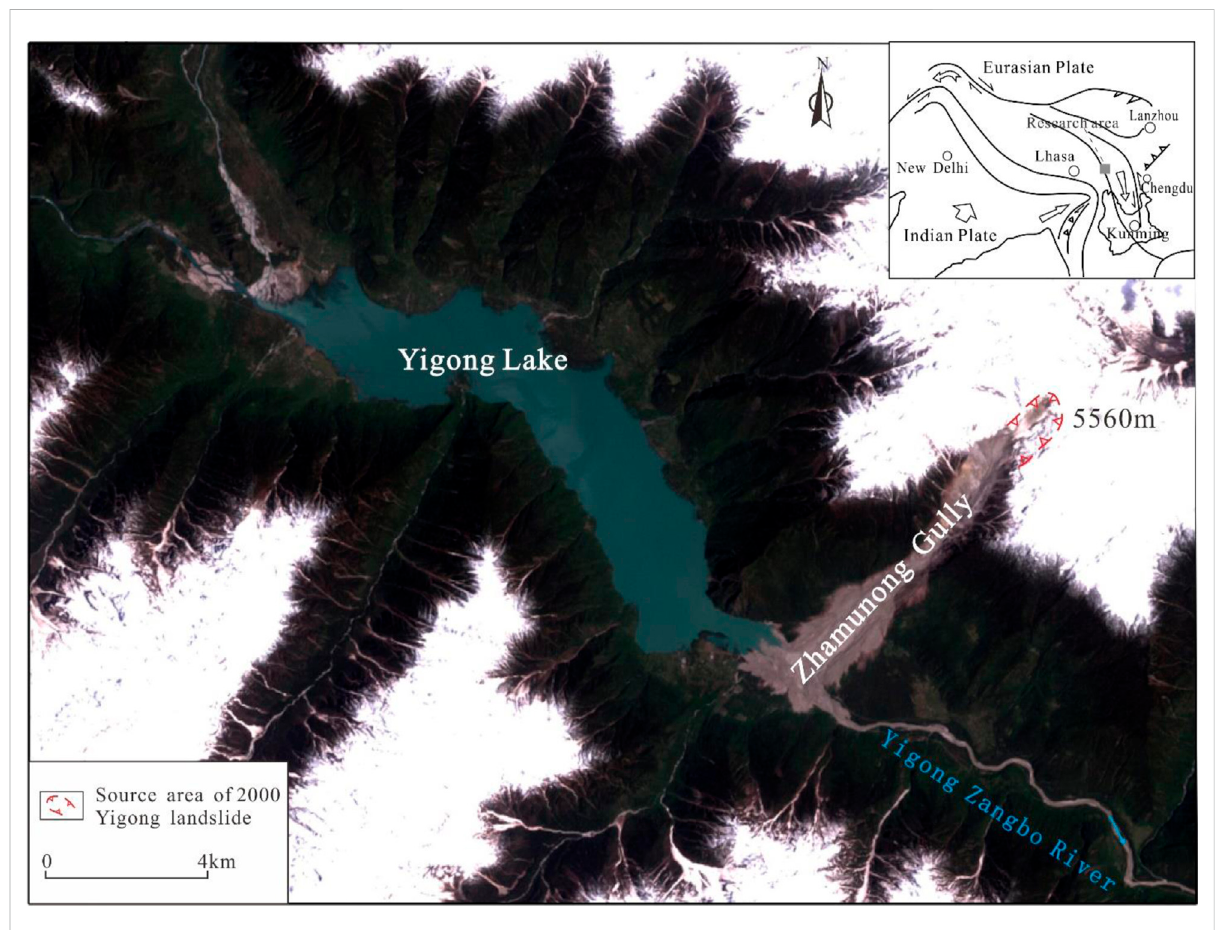
FIGURE 1 Location map of Yigong landslide area in 2000 (modi fi ed after Guo et al.,